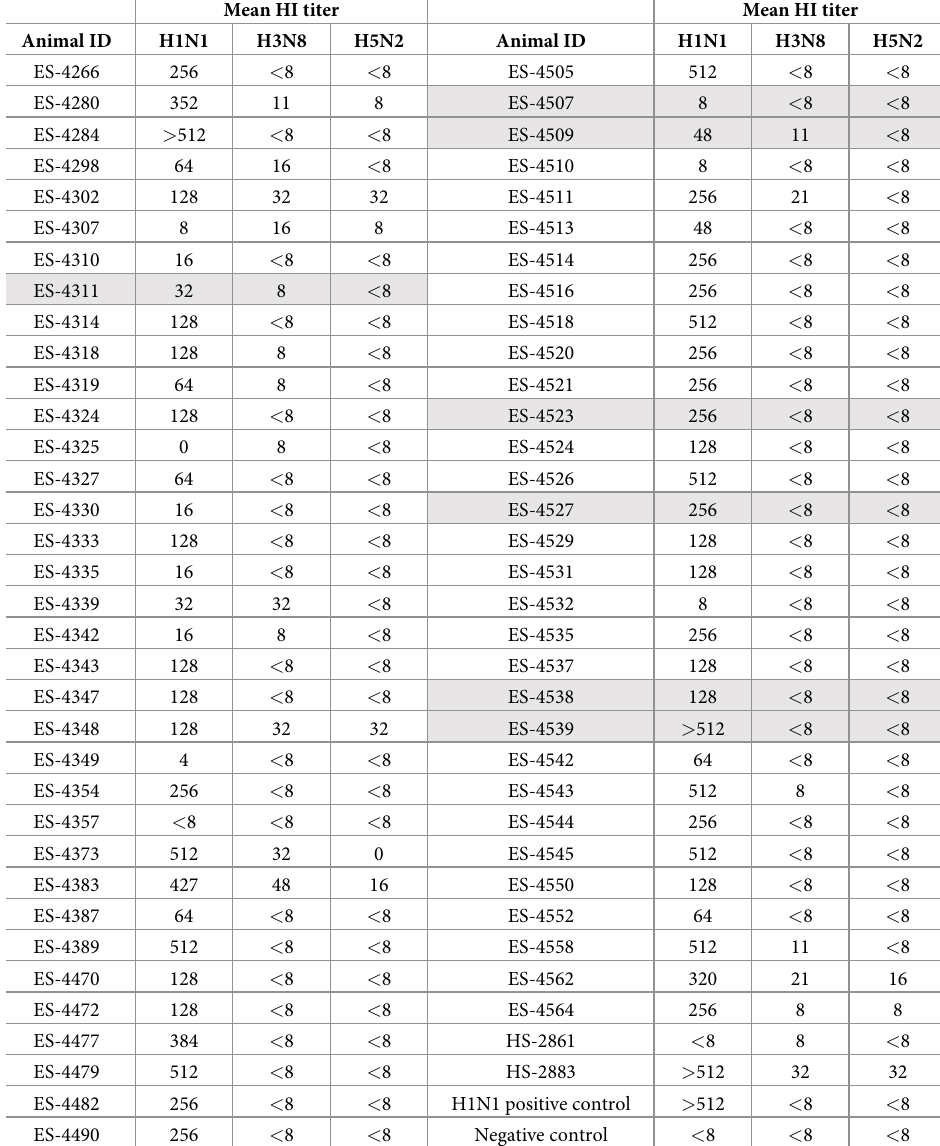
Table 2. IAV antibody hemagglutination inhibition (HI) assays detections in ELISA-IAV reactive Northern ele- phant seals on California coasts in 2018–2019. Animals shaded in grey also contained IAV RNA detectable by RRT-PCR; the same HI data for those animals is also reproduced in Table 2 for comparison with RNA values. Ferret serum from an animal that was experimentally inoculated with IAV H1N1 was used as a positive control. Positive con- trol sera for H3N8 and H5N2 were not available. The negative control consisted of serum